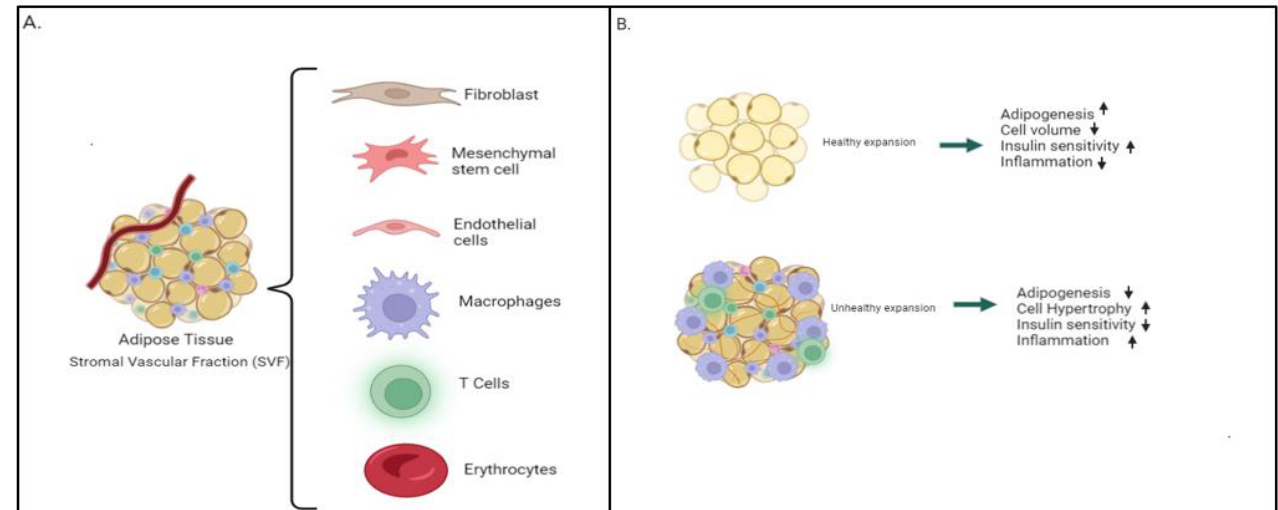
Figure 1. ( A ) The adipose tissue is primarily comprised of adipocytes which are surrounded by various vascular stromal cells such as depicted in the figure. 1/3 is formed by vascular stromal cells including fibroblast, mesenchymal stem cells, endothelial cells, macrophages, T cells. 2/3 of the frac- tion will be composed of adipocytes. ( B ) Adipose tissue dysfunction is a determinant of obesity causing metabolic complications . Lipotoxicity leads to obesity through ectopic deposition of lipids, Nonalcoholic fatty liver disease (NAFLD), insulin resistance, T2 diabetes and coronary heart dis- ease.